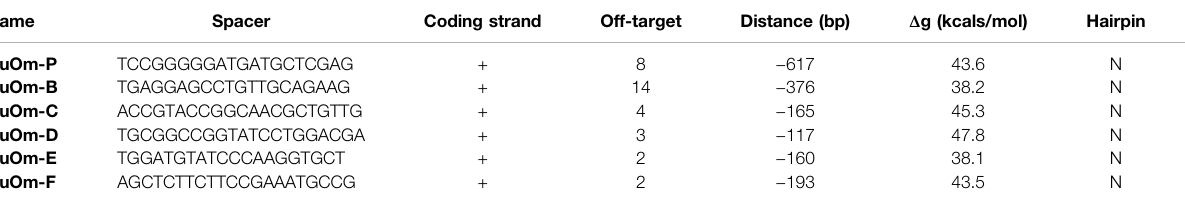
TABLE 1 | Information of the spacer sequences.